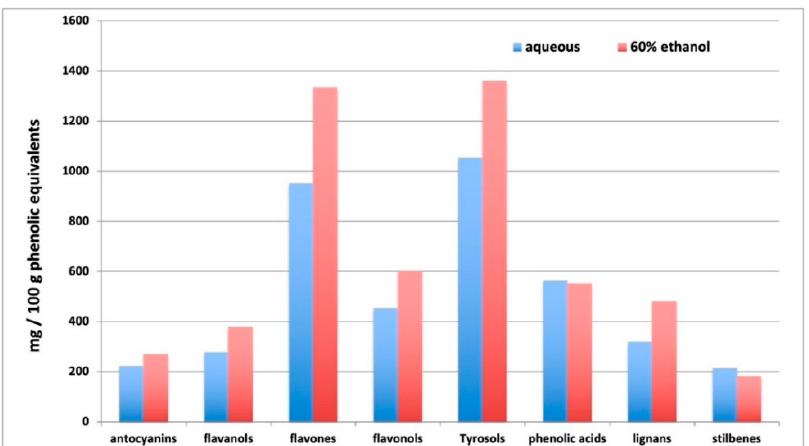
Figure 1. Cumulative semi-quantitative abundance (mg/100 g phenolic equivalents) of the different phenolic subclasses, as profiled by untargeted metabolomics in aqueous and EtOH:H 2 O 60:40 extracts.